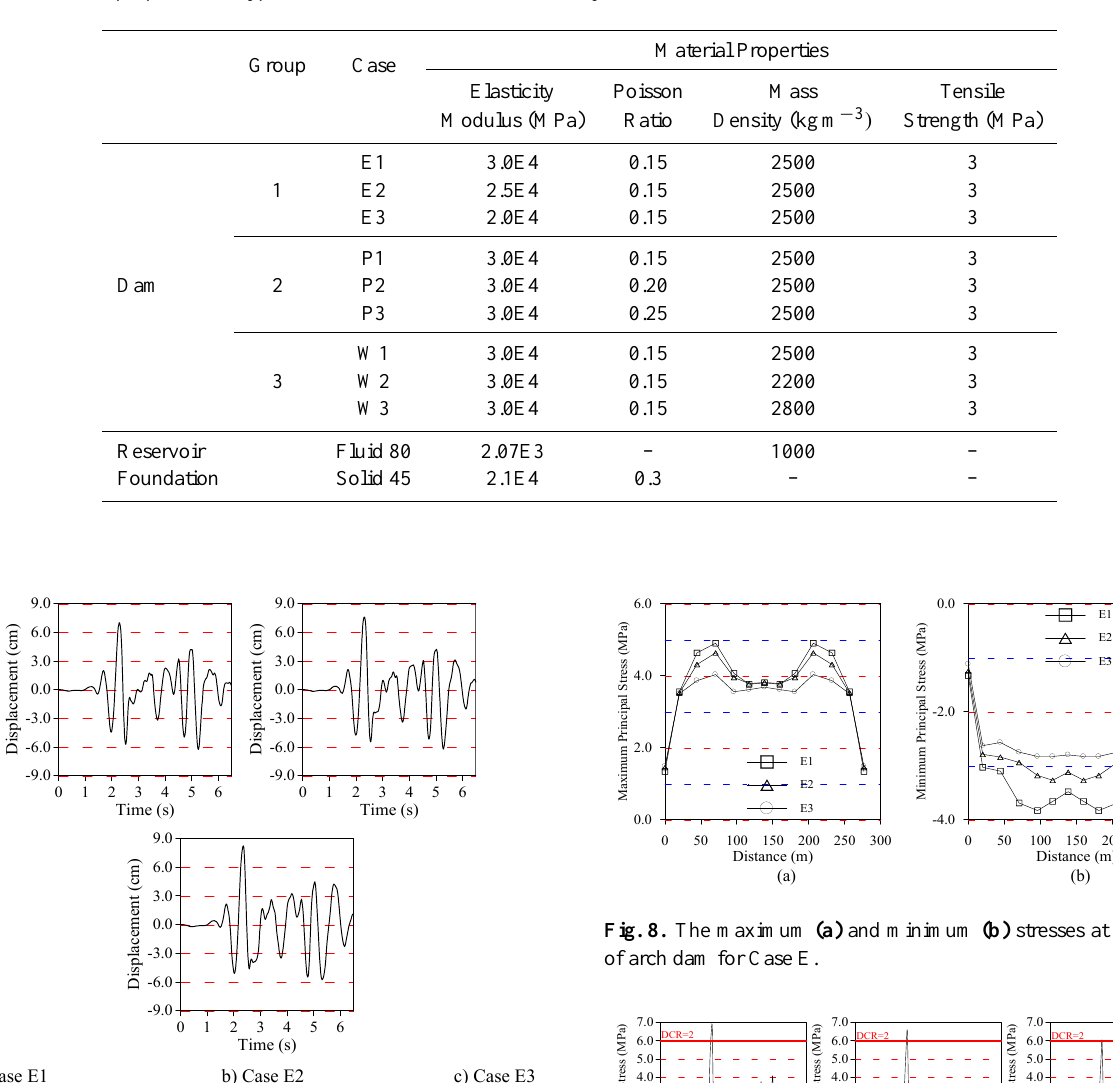
Table 1. Material properties of Type-5 arch dam-reservoir-foundation system.